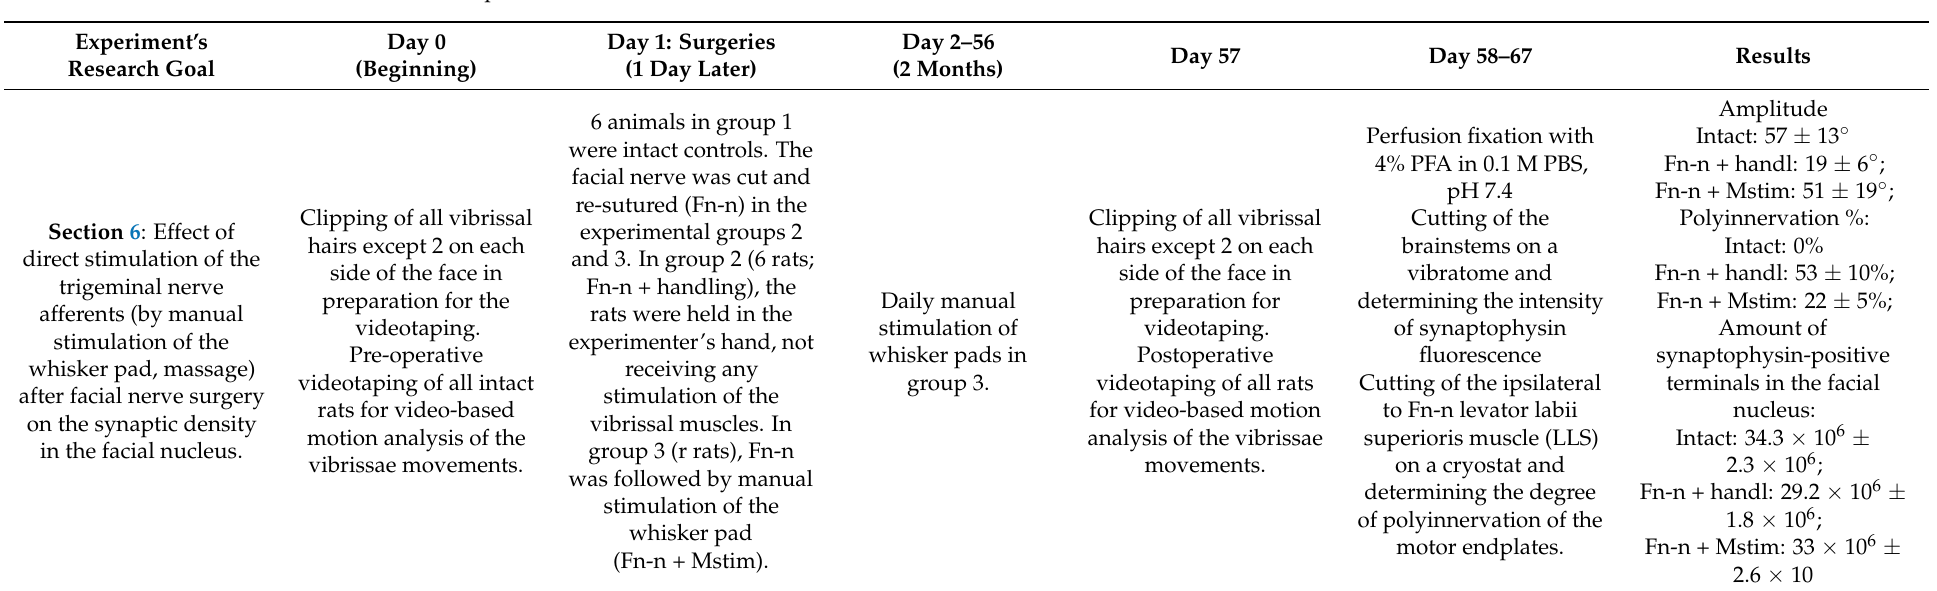
Table 6. Experimental design flow chart depicting animal grouping and sequence of the main procedures in the section describing the effect of direct stimulation of the trigeminal nerve afferents after facial nerve surgery (Fn-n) on the synaptic density in the facial nucleus, the quality of target reinnervation and recovery of vibrissal motor performance. Mstim, manual